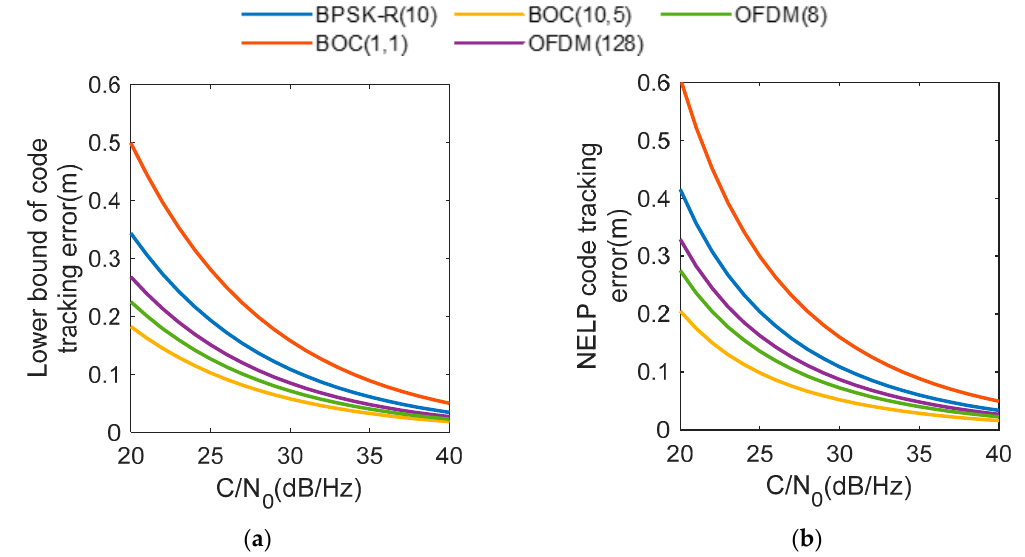
Figure 10. Comparison between the navigation signal and traditional signal. ( a ) Lower bound of code ring tracking accuracy; ( b ) Incoherent lead–lag code loop tracking error.